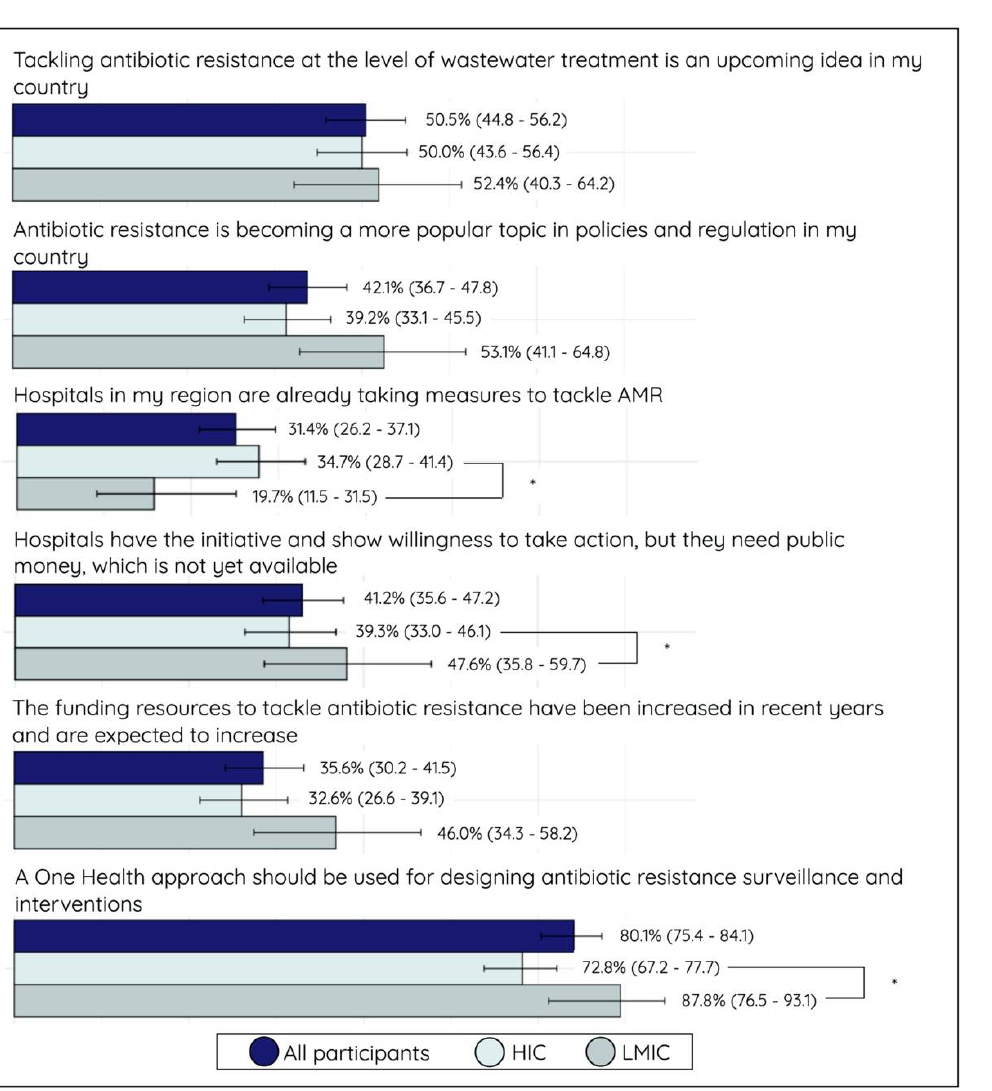
Figure 5. Bar plot (proportion (%) with 95% confidence interval) on the second part of statements assessing the political knowledge, attitudes, and perceptions (KAP) of all participants, stratified for high-income country (HIC) and low- and middle-income country (LMIC) participants. The proportion represents participants who answered the statement correctly with agree or strongly agree. Significance: * p < 0.05.